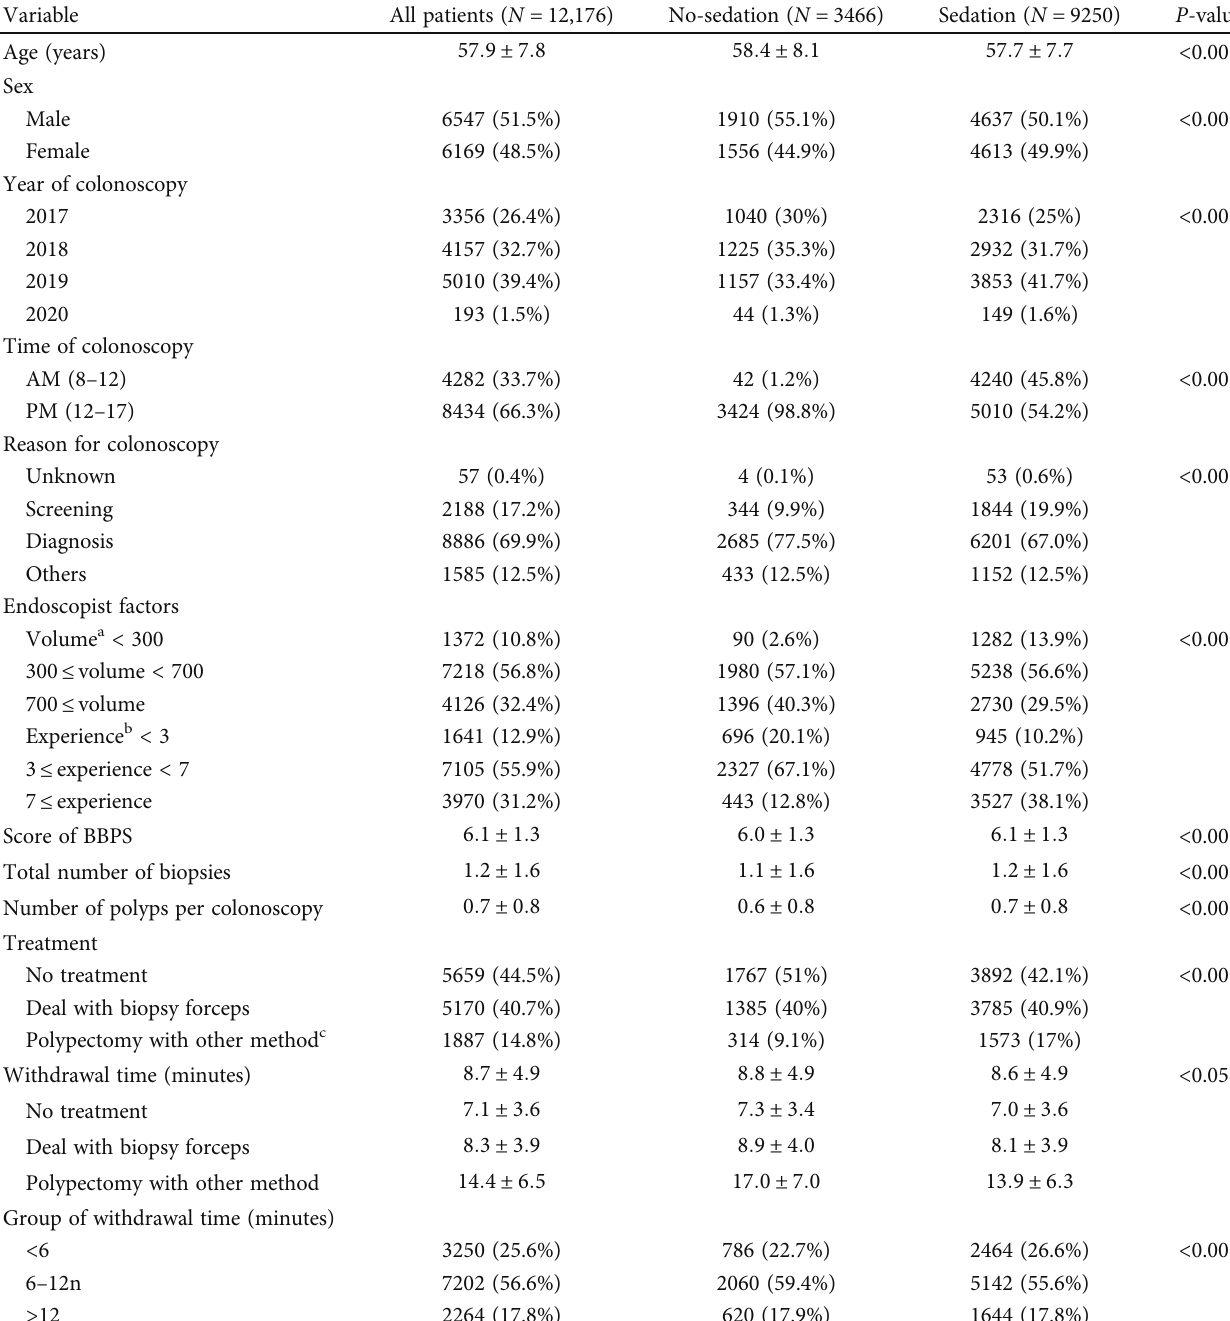
Table 1: Characteristics of the